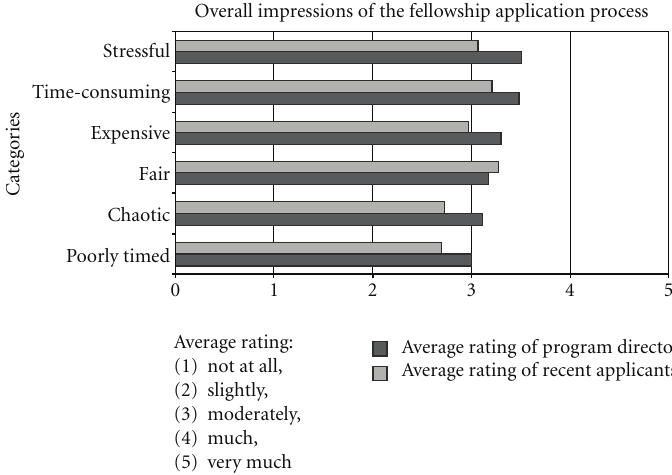
Figure 6: Bar chart comparing how program directors believe applicants regard the fellowship application and selection process with how recent fellows regard the process.